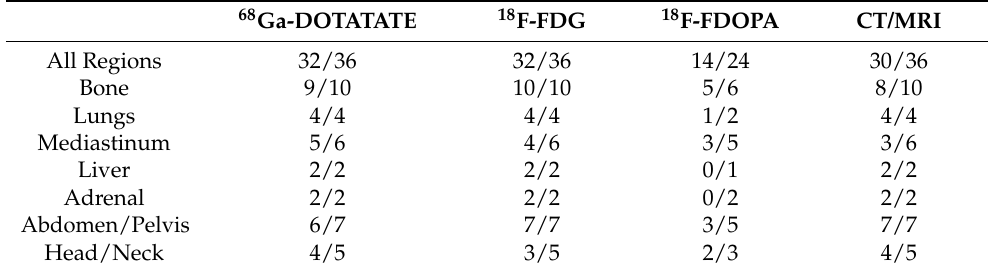
Table 3. Imaging modality detection of a positive lesion in all anatomic regions and individual anatomic regions.